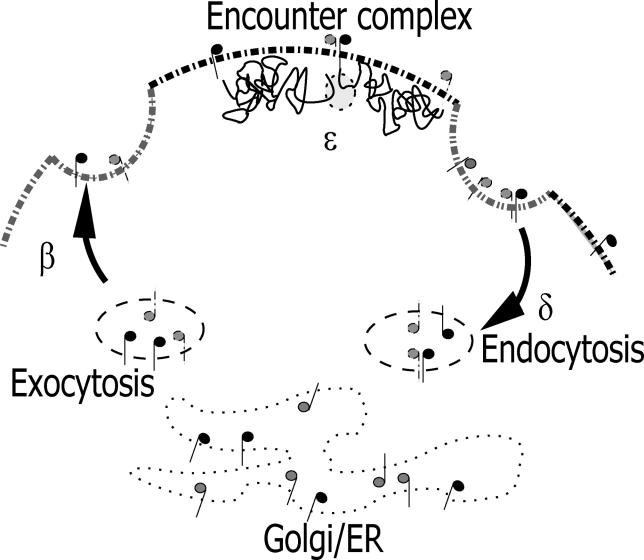
Illustration of the Model for the Receptor Dimerization ProcessAs soon as receptors are introduced onto the cell surface, they undergo isotropic Brownian motion. At any given time, there is a small constant probability that a protein may be removed from the cell surface via endocytosis. If at any time two receptors of different type come within close proximity, they may form an active dimeric complex with probability p.